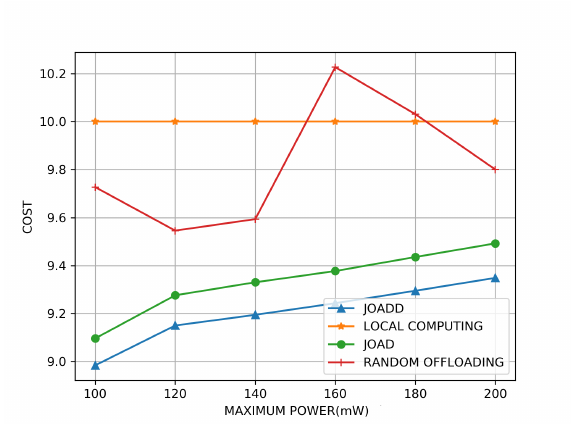
Figure 6. The effect on cost of different maximum transmission power.